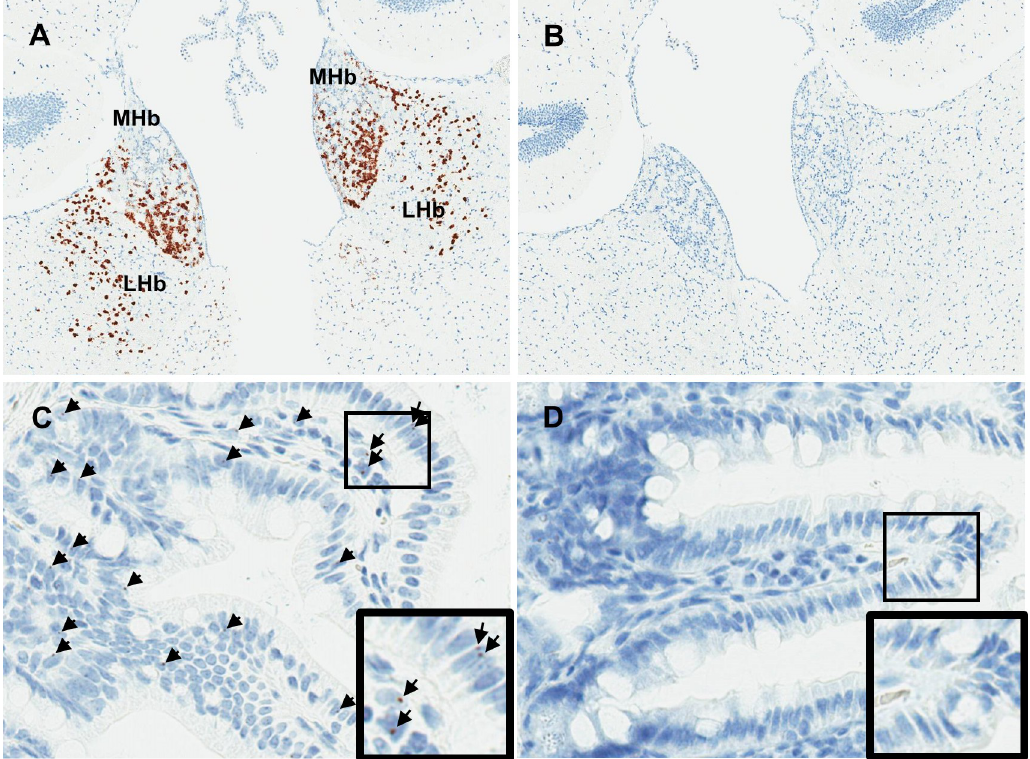
Fig 2. Gpr151 -/- mice do not express Gpr151 mRNA. (A and B) Sections of mouse brain containing the medial habenula (MHb) and lateral habenula (LHb) from Gpr151 +/+ and Gpr151 -/- mice, respectively, stained with a riboprobe for Gpr151 . (C and D) Sections of mouse intestine containing the ileum and jejunum from Gpr151 +/+ and Gpr151 -/- mice, respectively, stained with a riboprobe for Gpr151 . Black arrows indicate cells containing Gpr151 mRNA. Inset shows higher magnification of boxed region.